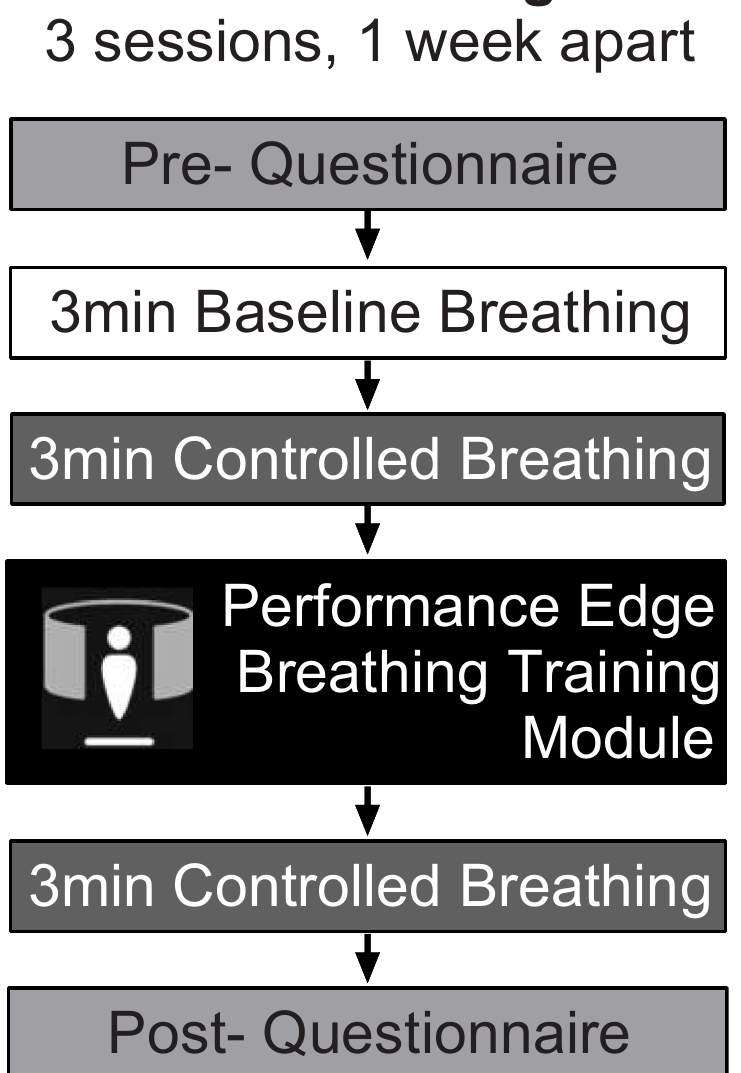
Fig 1. Pilot efficacy trial session design. Participants attended 3 training sessions, each held approximately 1 week apart. Each session consisted of pre-training questionnaires, followed by baseline breathing data collection (baseline and controlled). Participants then completed the Performance Edge VR Controlled Breathing module. After training, controlled breathing was again assessed and participants completed post-training questionnaires. All breathing data was captured using the Equivital